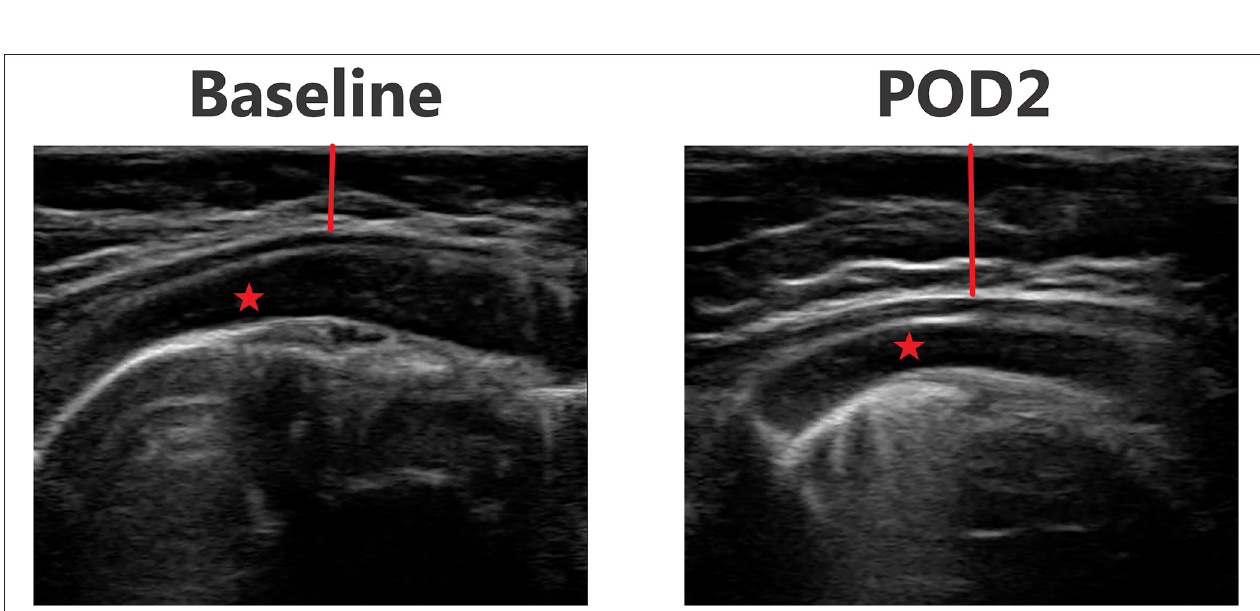
FIGURE 2 | Comparison of mean baseline subcutaneous tissue thickness between controls and surgical neonatal subjects, by right-sided body site. *, p < 0.05. (A) Anterior chest; (B) Lateral chest; (C) Lateral abdomen; (D) Anterior thigh.